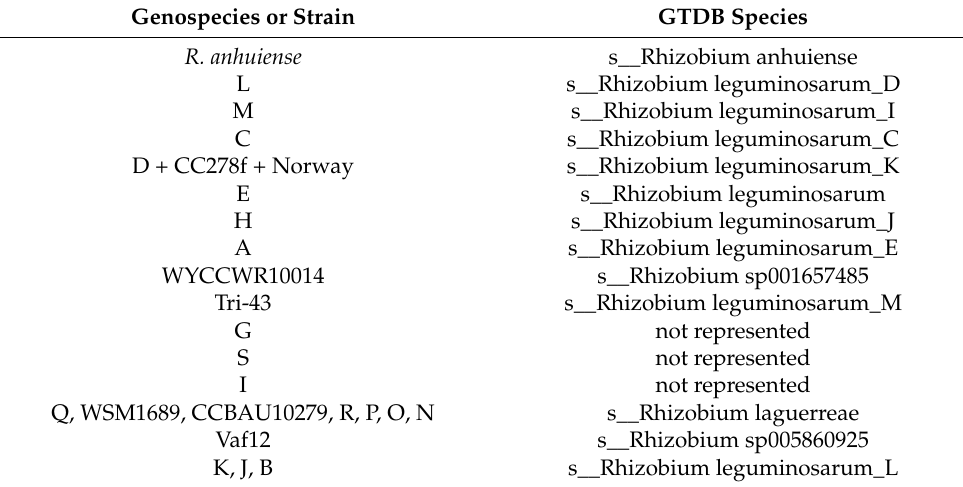
Table 1. Equivalence between our genospecies and the species-level taxa defined in the Genome Taxonomy Database